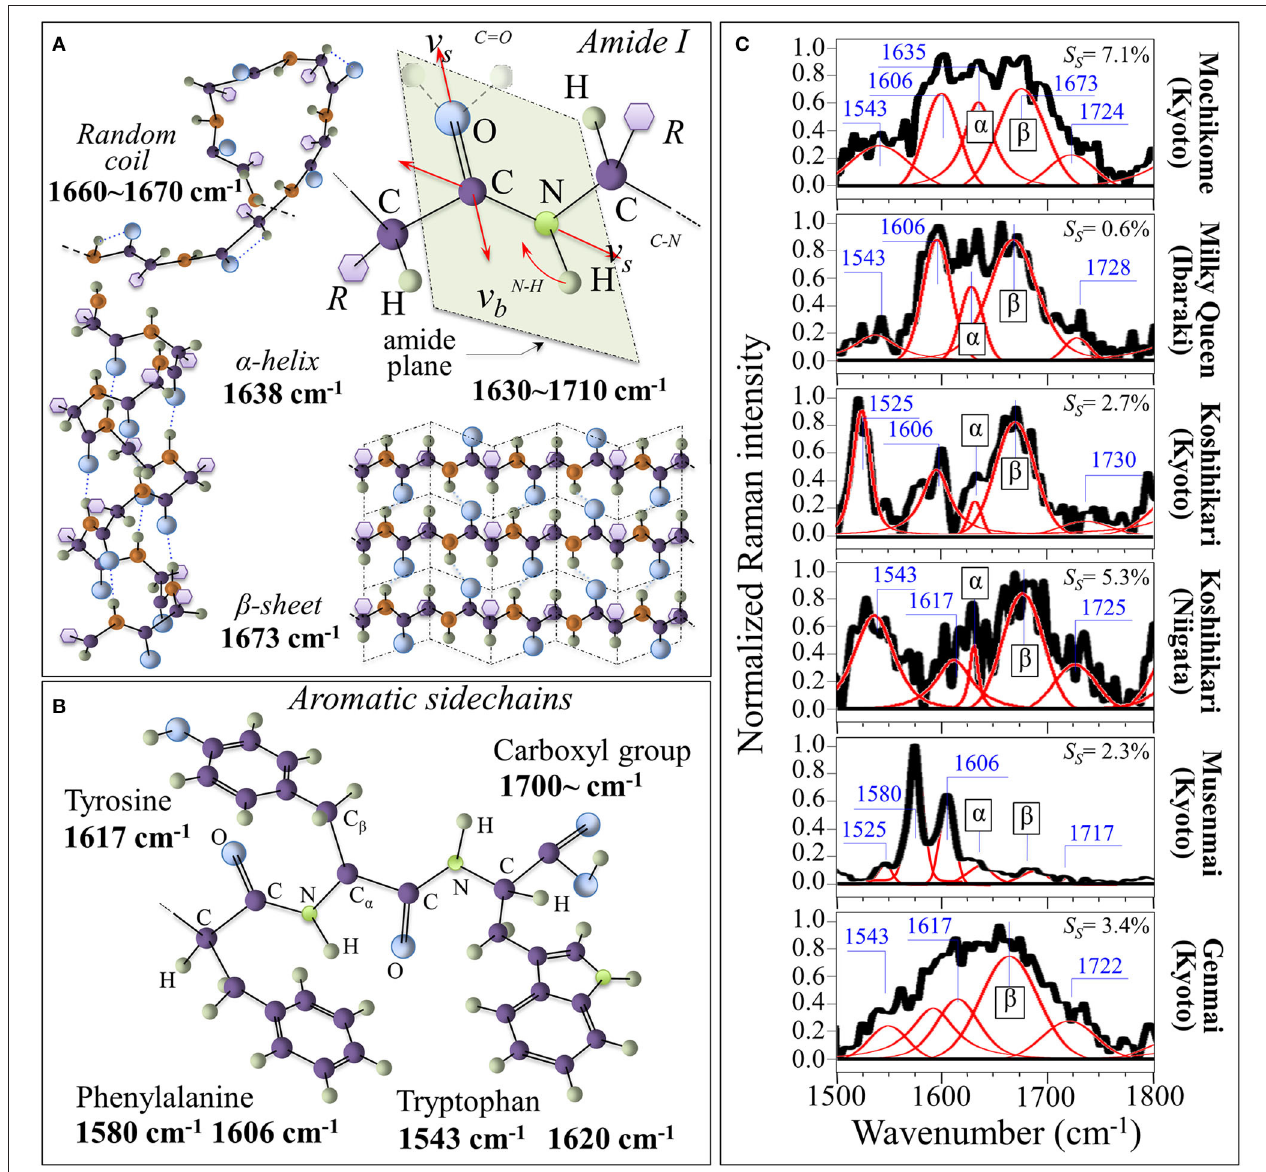
FIGURE 4 | (A) Amide I vibrational modes and schematic drafts of the secondary structures of proteins in which it takes place (cf. related Raman frequencies in inset); (B) aromatic sidechains of tyrosine, phenylalanine, tryptophan, and carboxyl group (with related Raman frequencies in inset). In (C) , deconvoluted Raman spectra in the Amide I region are shown for the six investigated rice cultivars (the α and β labels represent α -helix and β -sheet, respectively). In inset, the fraction of succinylated lysine is shown as computed according to the relative intensity of the band at 1,720–1,730 cm − 1 (cf.